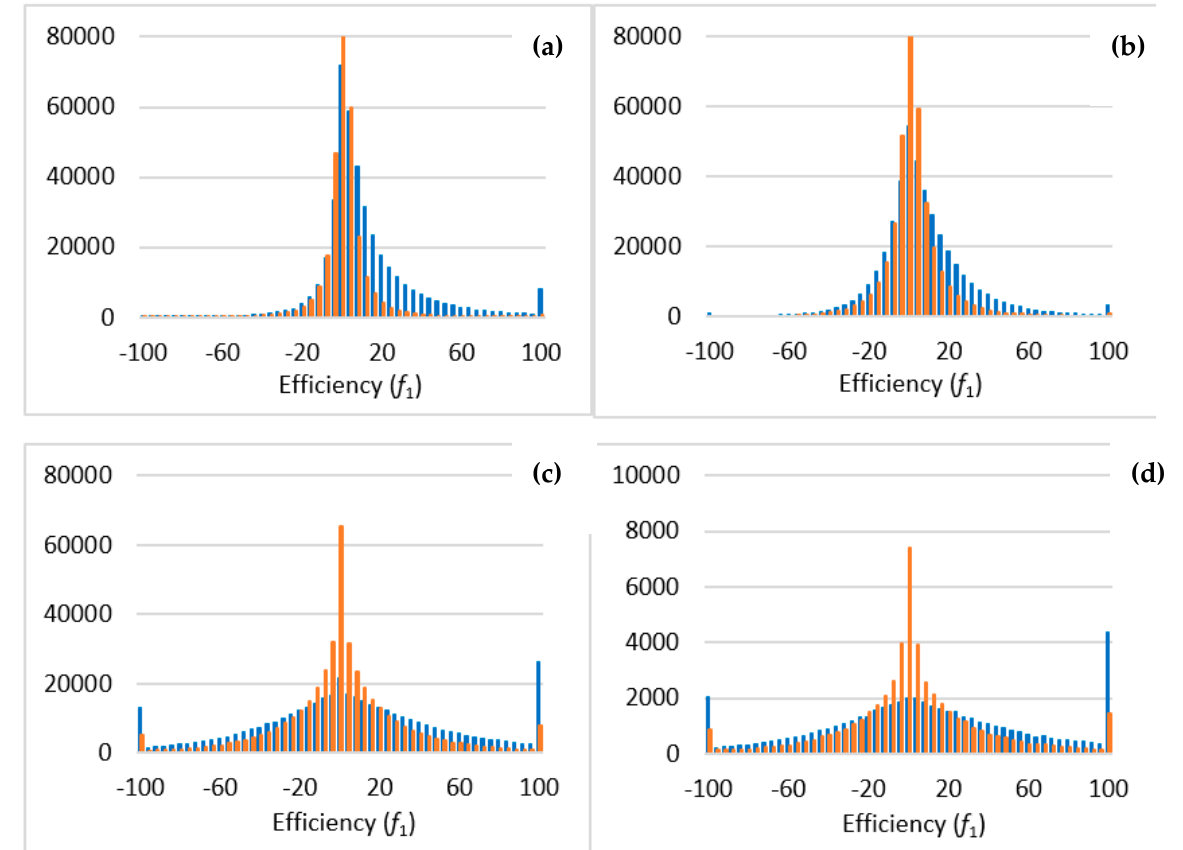
Figure 1. Absolute values larger than 100 are unified in one column in each tail of the distribution function. Blue: permissive metadata use, brown: restrictive metadata use. Upper left panel ( a ) CRMSEm, upper right panel ( b ) CRMSEy, bottom left panel ( c ) Trend bias for individual time series (Trbias), bottom right panel ( d ) Network mean trend bias (Trnetb).